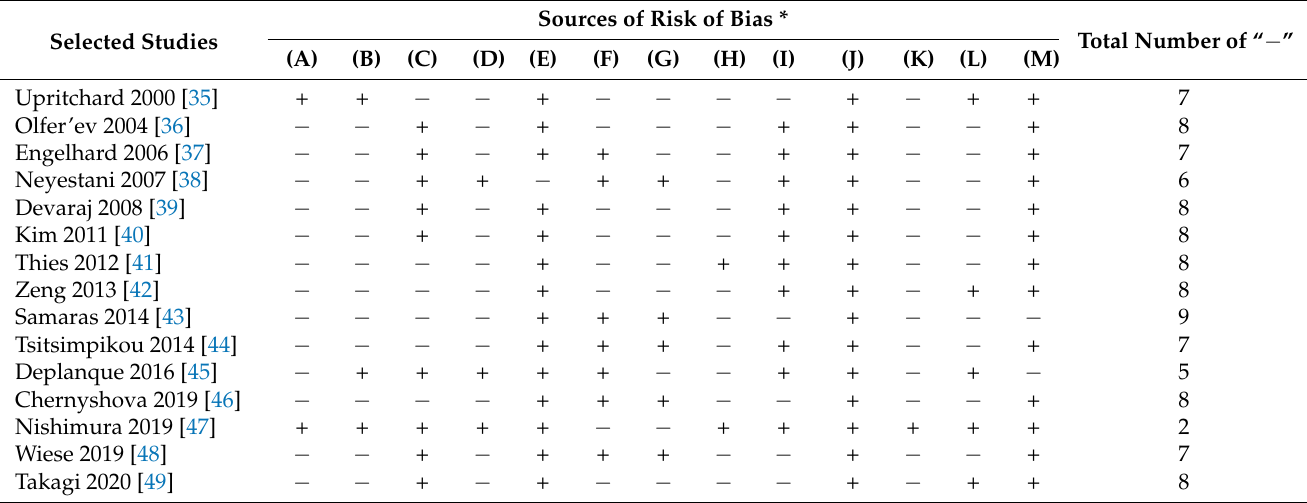
Table 1. Quality assessment of the selected